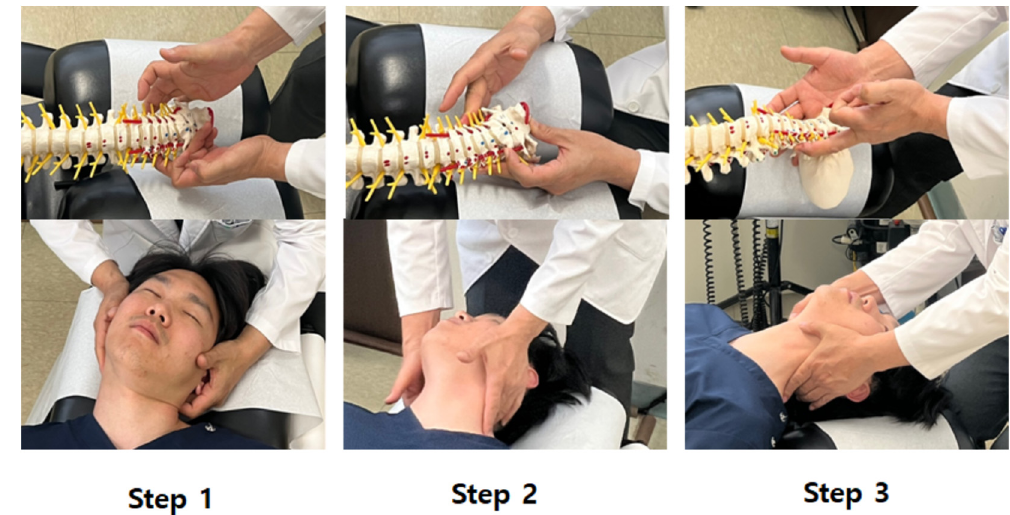
Figure 1. Supine position cervical JS distraction and correction. Step 1, push articular process alternately left and right; Step 2, lift articular process alternately left and right; and Step 3, while lifting both sides of the articular process, traction toward the head.